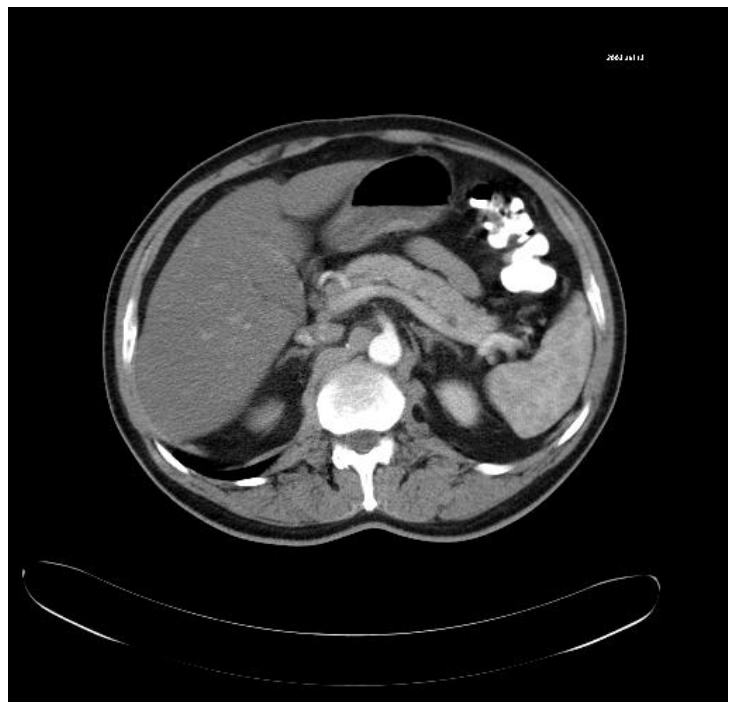
FIGURE 1 . CT scan of the upper abdomen and pelvic demonstrating Grade A pancreatitis.